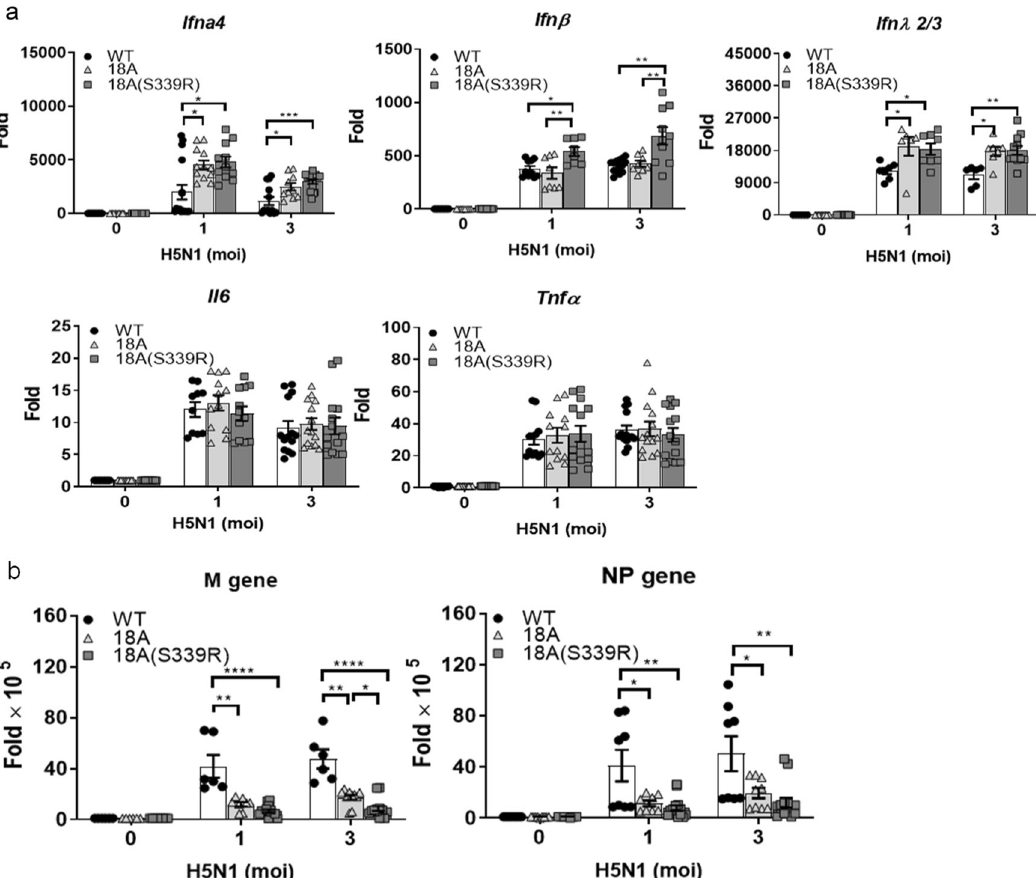
Fig. 3 CLEC18A and CLEC18A(S339R) modulate type I/III IFN expression and virus replication in lung alveolar epithelial cells. Pulmonary alveolar epithelial cells (2 × 10 5 /well) from WT, ROSA-CLEC18A, and ROSA-CLEC18A(S339R) mice were incubated with H5N1 virus (MOI = 2) for 12 h, followed by harvesting cells to determine cytokine expression ( a ) and virus replication ( b ) by quantitative RT-PCR ( n = 7 – 12). One-way ANOVA was performed. * P < 0.05, ** P < 0.01, *** P < 0.001 and **** P < 0.0001, for WT group versus group of CLEC18A or